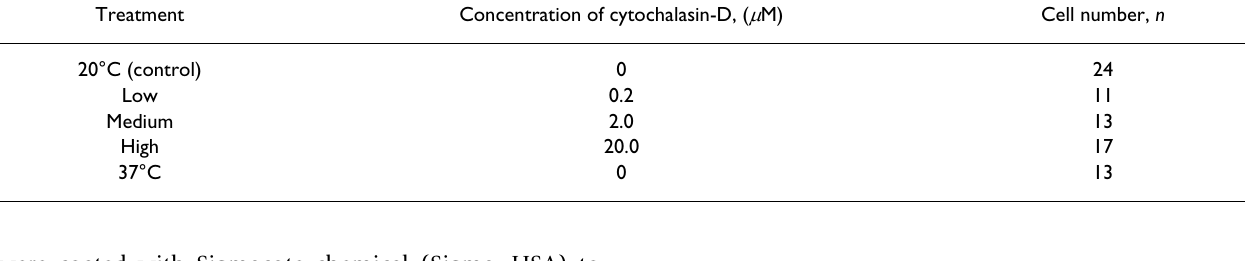
Table 2: The corresponding cell number of hMSCs under the different experimental conditions